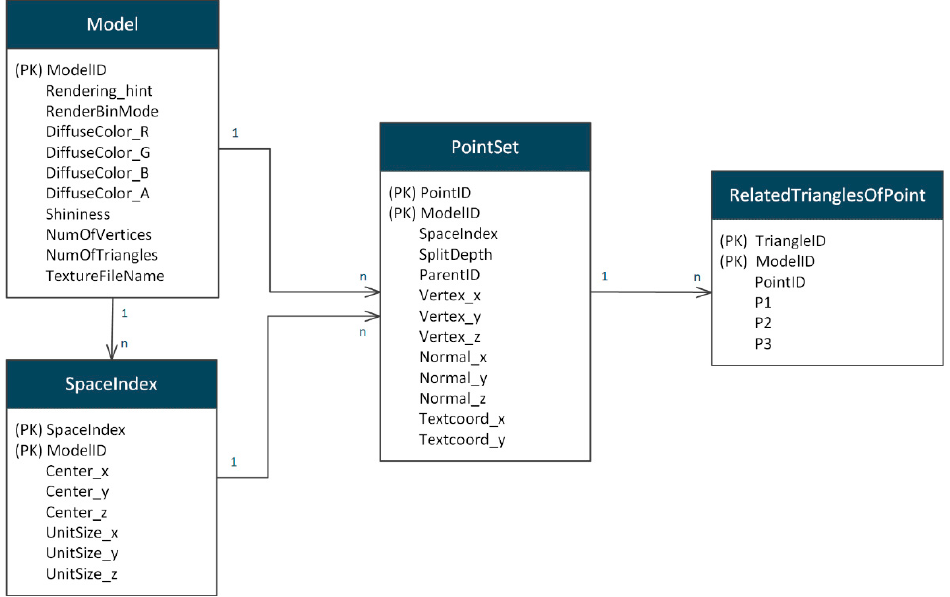
Figure 9. Database diagram.